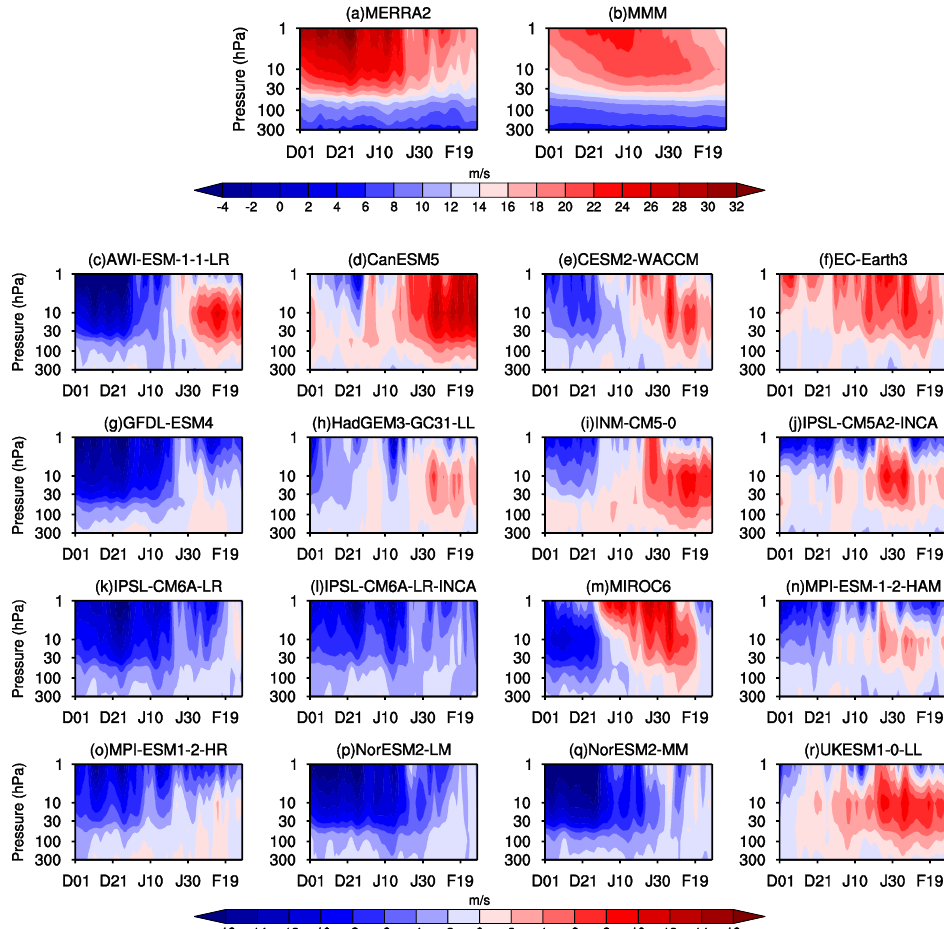
Figure 5. Time evolution of climatological mean of daily zonal mean zonal wind (units: m/s) over the levels between 1 – 300 hPa in the polar cap (60° – 90°N) during winter derived from ( a ) MERRA2, ( b ) multi-model mean for the period of 1980/81 – 2013/14. ( c – r ) Differences in climatological mean of zonal wind between individual CMIP6 model simulations and MERRA2 (D01 means 01, December; J10 means 10, January; F19 means 19, February).